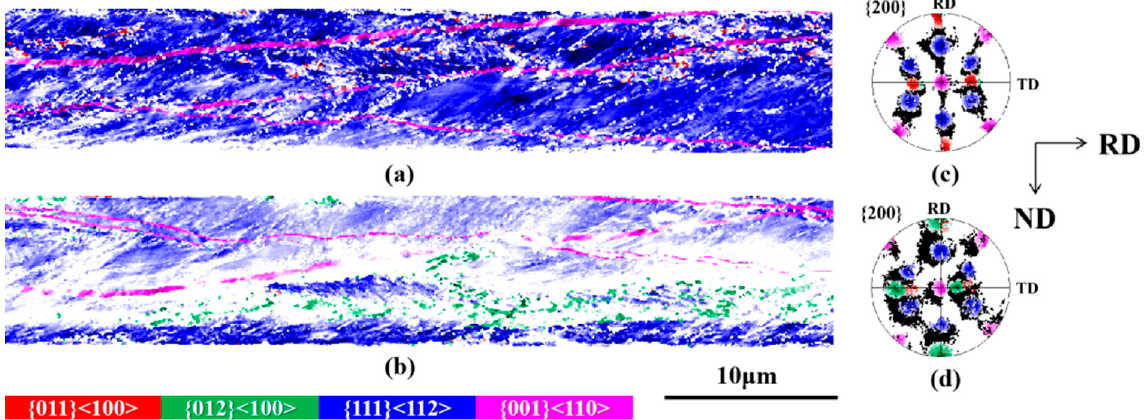
Figure 8. The effect of deviation angle of Goss oriented grain on twinning orientation in the lateral plane: (a) 3 ° deviated Goss oriented grain; (b) 10 ° deviated Goss oriented grain; EBSD measure- ment step size=0.5 μ m.